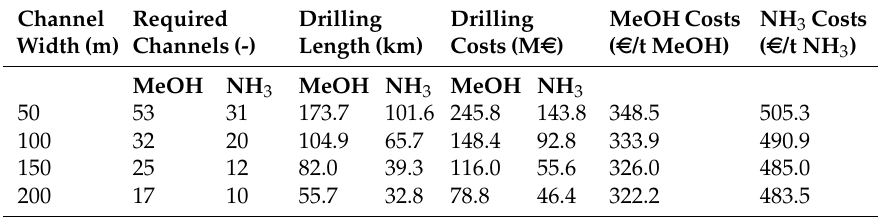
Table 22. Different UCG channel widths and resulting levelized methanol and ammonia